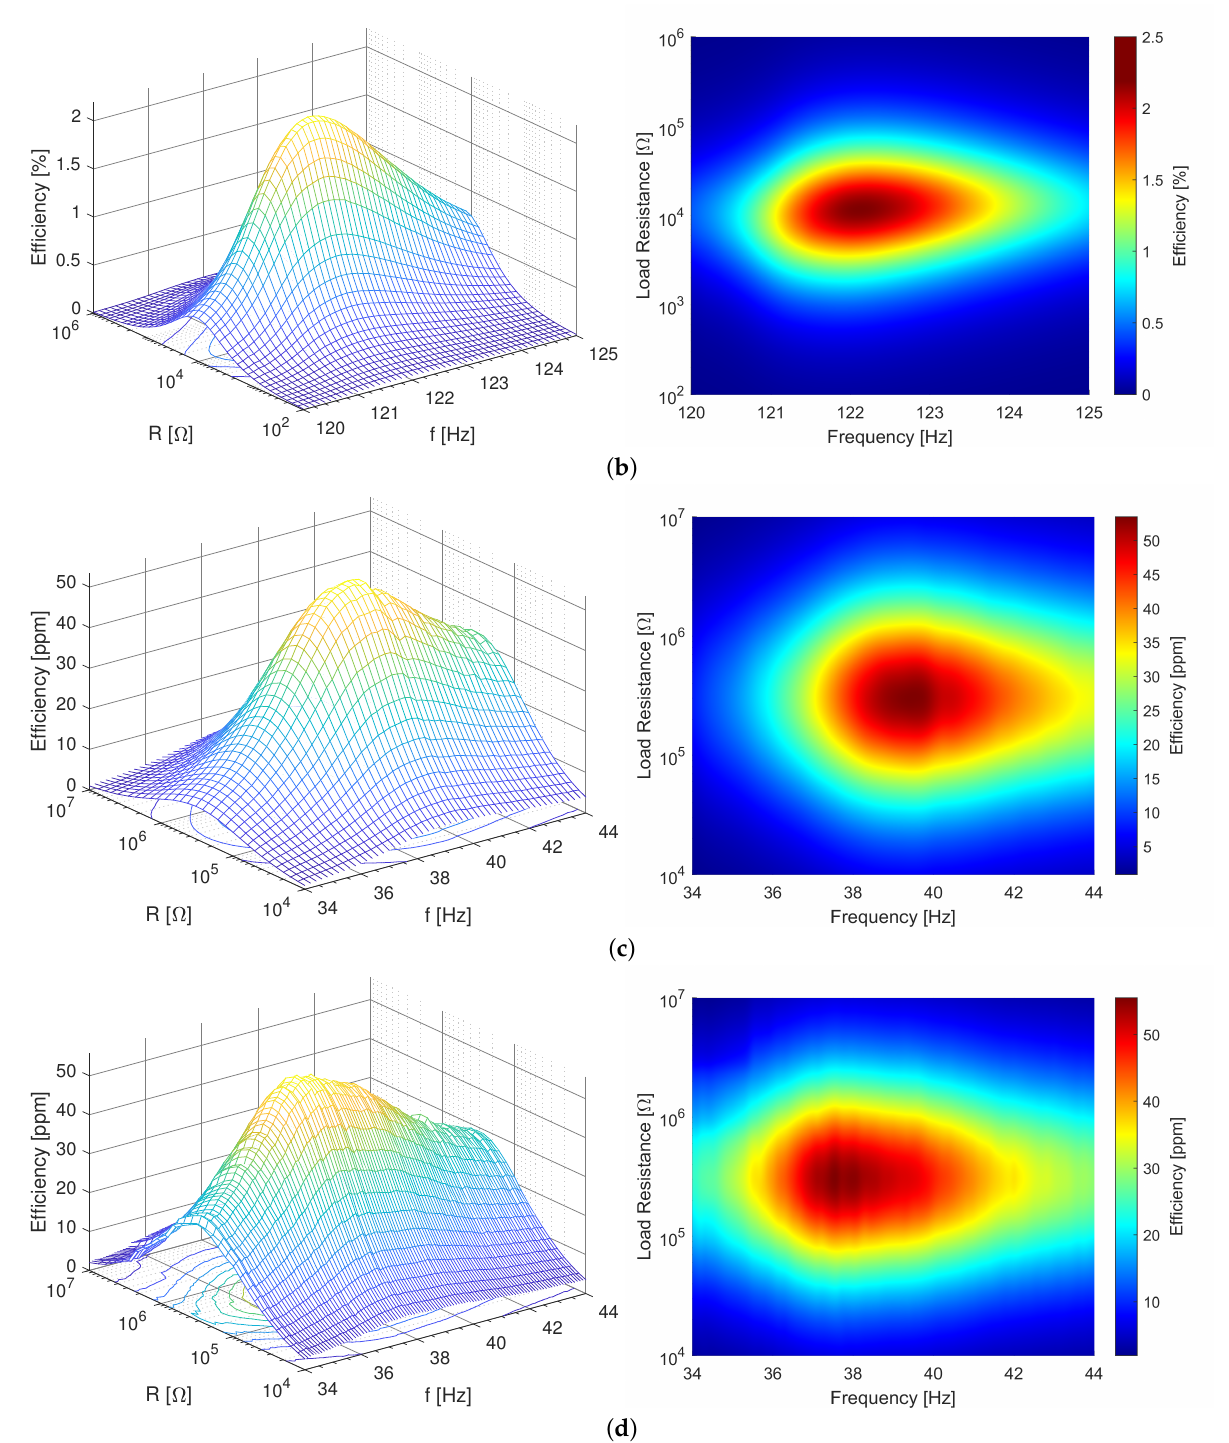
Figure 6. The proposed efficiency rates measured near the harvesters’ resonance frequencies, at 1 g zirconate titanate (PZT) PEH, ( a , b , respectively); the polyvinylidene fluoride (PVDF) PEH, ( c , d , respectively). The 3D plots and the top views are shown on the left-hand and the right-hand sides, respectively. Note the different efficiency scales for the two